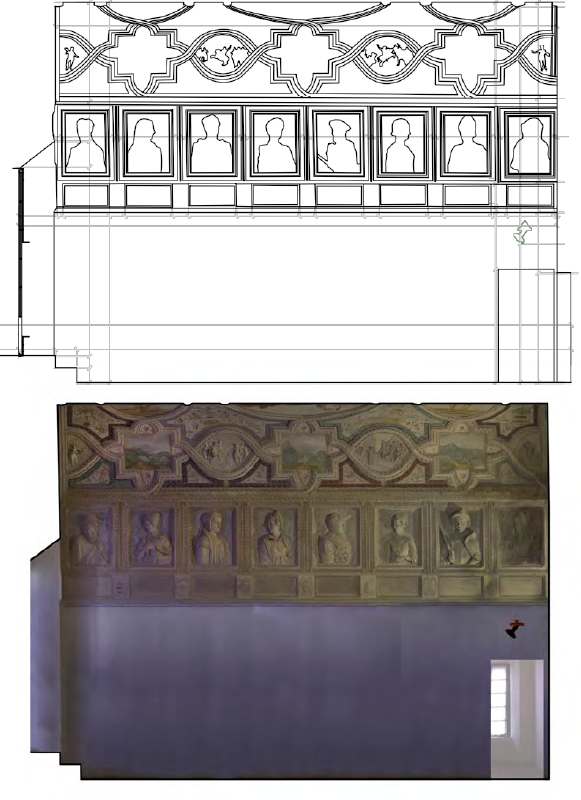
Figure 14. Sections of the room (by photos and by lines) coming from Photoscan projections